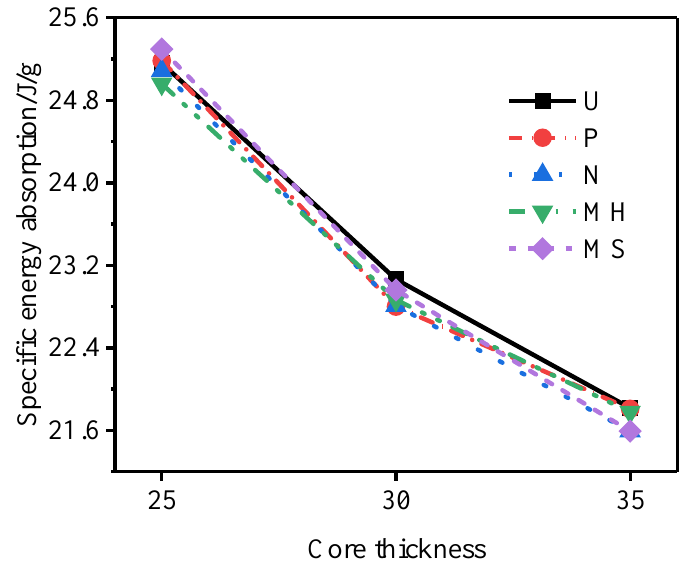
Figure 25. Total specific energy absorption of sandwich tubes with different core thicknesses.